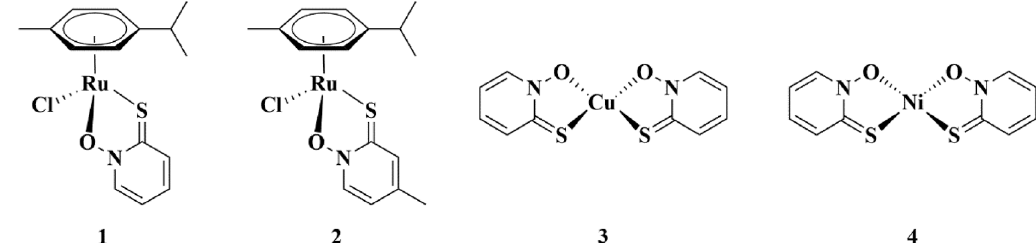
Figure 1. Structures of tested metal catalysts 1) Ru-Pth, 2) Ru-Pth-Me, 3) Cu-Pth and 4) Ni-Pth.